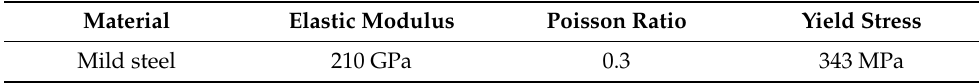
Table 3. Material properties for the tested